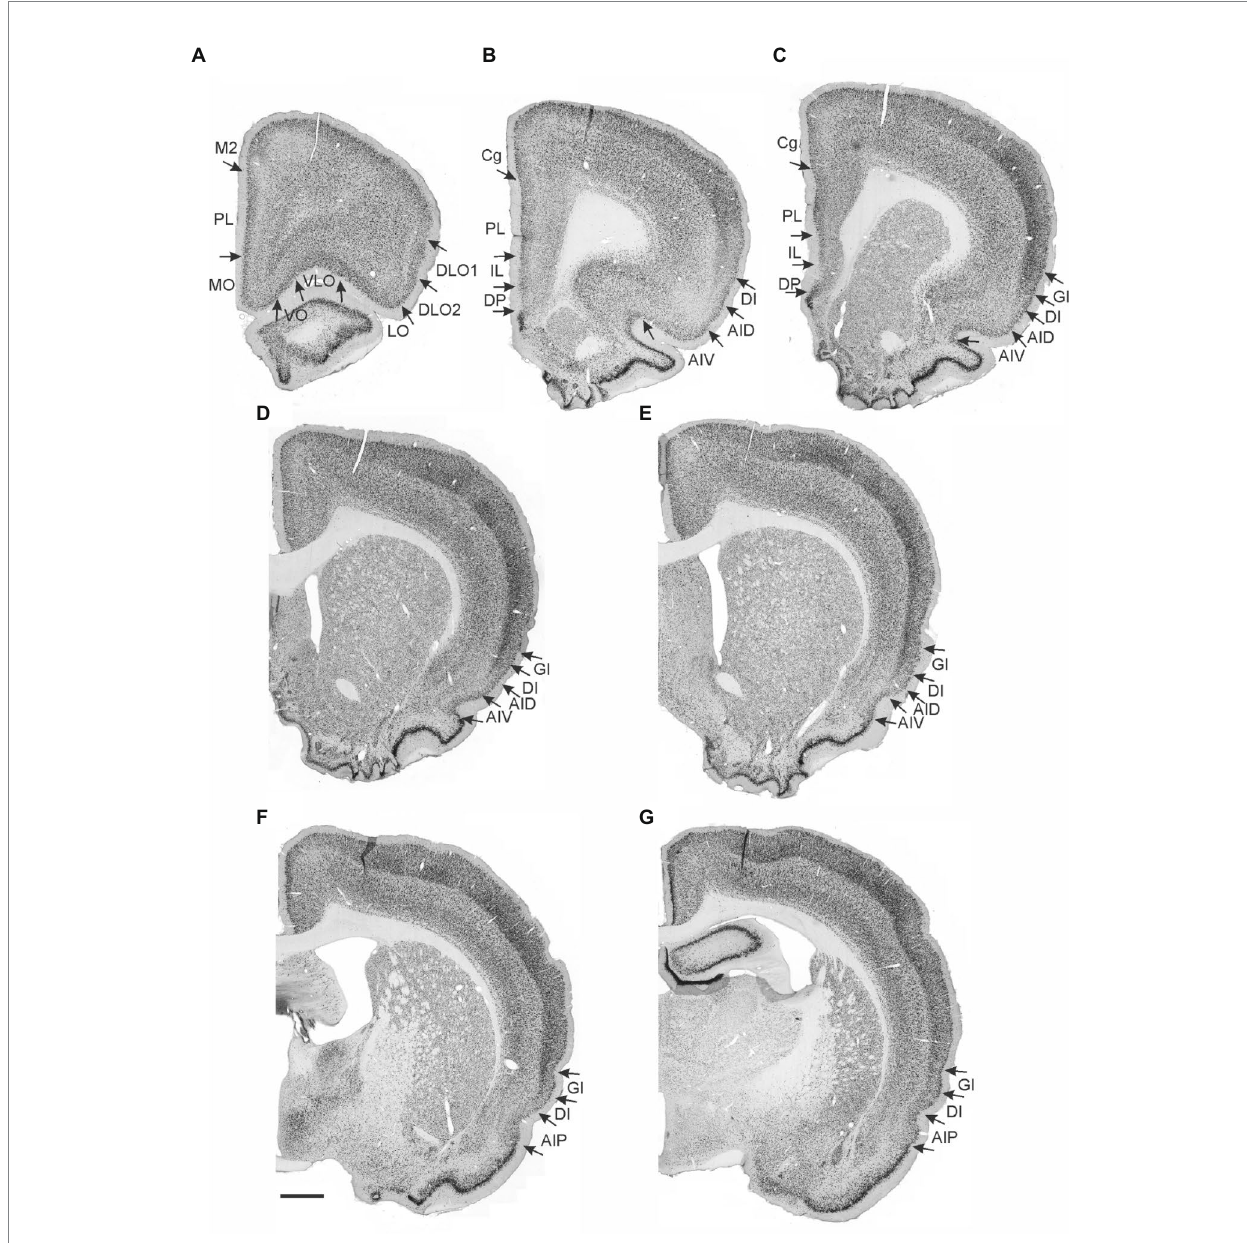
FIGURE 1 Photomicrographs of NeuN-stained coronal sections of the rat brain taken at different rostrocaudal levels through the frontal part of the brain. The coronal sections are arranged from rostral to caudal. (A–C) Most rostral sections showing the orbital fields and medial prefrontal regions and the replacement of orbital cortex with insular cortex. (B,C) Sections showing the anterior insular domain at rostral (B) and caudal positions (C) . (D–E) Sections showing the posterior insular domain at rostral (D) and caudal positions (E) . (F–G) Sections showing the parietal insular domain at rostral (F) and caudal (G) positions. Arrows indicate borders between cortical areas. Scale bar equals 1,000 μ m. AIV, ventral agranular insular cortex; AID, dorsal agranular insular cortex; AIP, agranular parietal insular cortex; Cg, anterior cingulate cortex; DI, dysgranular insular cortex; DLO, dorsolateral orbitofrontal cortex; DP, dorsal peduncular cortex; GI, granular insular cortex; IL, infralimibic cortex; LO, lateral orbitofrontal cortex; MO, medial orbitofrontal cortex; M2, secondary motor cortex; PL, prelimbic cortex; VLO, ventrolateral orbitofrontal cortex; VO, ventral orbitofrontal